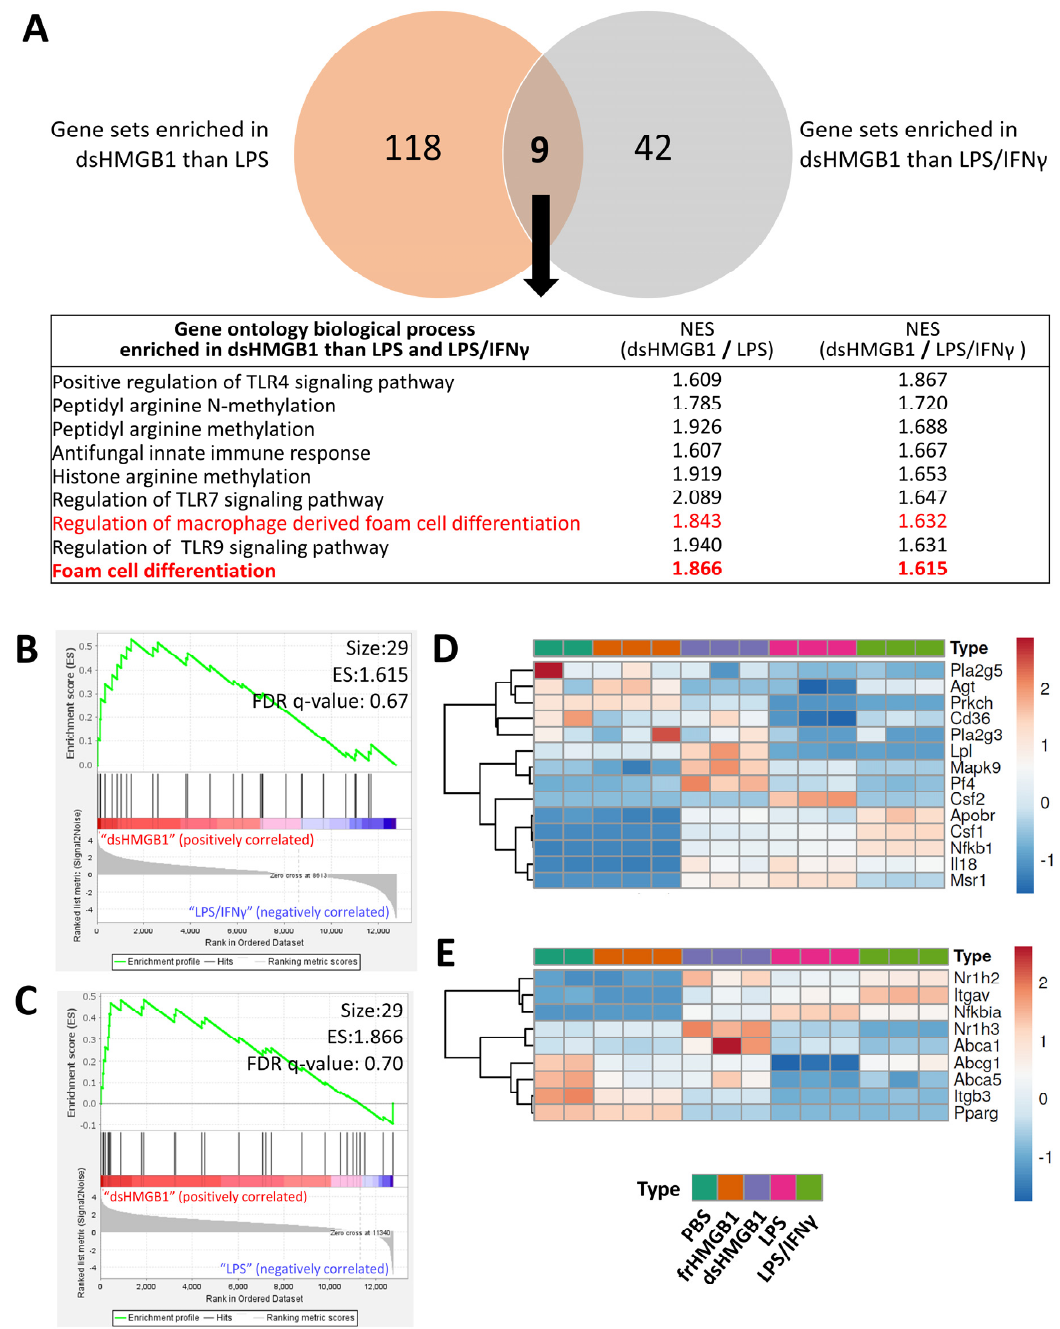
Figure 5. Foam cell differentiation-related gene sets were enriched by dsHMGB1 than LPS and LPS/IFN γ . ( A ) GSEA analysis revealed that 127 gene sets were enriched by dsHMGB1 than LPS, 51 gene sets were enriched by dsHMGB1 than LPS/IFN γ (NES cut-off = 1.6). Nine sets were commonly enriched, among which two were related to foam cell differentiation. ( B ) Foam cell differentiation was enriched by dsHMGB1 (left, red) comparing with LPS/IFN γ (right, blue). ( C ) Foam cell differentiation was enriched by dsHMGB1 (left, red) comparing with LPS (right, blue). ( D, E ) The genes included in positive (D) and negative (E) regulation of macrophage-derived foam cell differentiation (GO:0010744 and GO:0010745) were listed and heatmap which was created based on the normalized gene counts in each sample. Colour intensity was scaled within each row so that the highest value corresponds to red and the lowest to blue. Abbreviation: ES, enrichment score; NES, normalized enrichment score; FDR, False Discovery Rate.